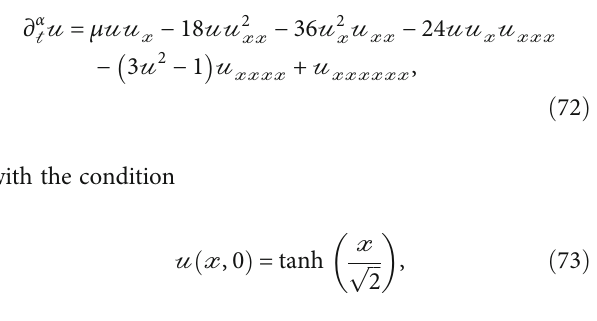
to α = 1 and α = 0 : 75 on ½ − 10, 10 (cid:2) × ½ 0, 1 (cid:2) . While the frac- tional level curves of u 3 ð x , t Þ for FCH4 model (40) and (62) are shown in Figure 6 compared to the third approxi- mate solutions obtained in [24] for fi x t = 1 on ½ − 15, 15 (cid:2) for various α values when λ = − 0 : 05 and λ = 0 : 05 . Error esti- mate for the third approximate solutions of FCH4 model (40) and (62) is provided in Table 4 by computing the abso- lute errors j u 3 − u q HAM j and j u 3 − u NIM j based on